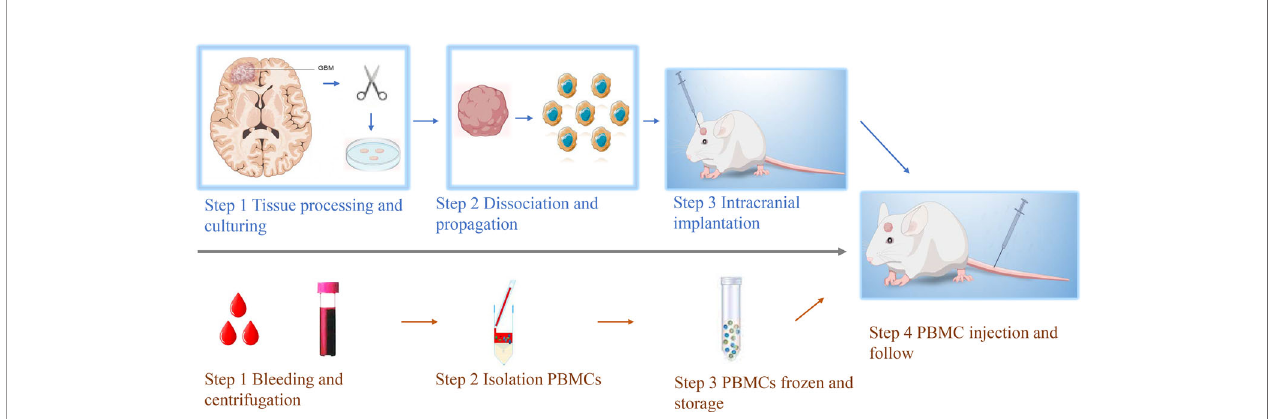
FIGURE 1 | Work fl ow of establishing GBM HPDOX mice models. Top, the work fl ow of establishing the GBM PDOX model. Tumor specimens obtained from surgery were dissociated to be single tumor cells. Then tumor cells were cultured with proper conditions to enhance the formation of GBM neurospheres (Top step 1). After the obtainment of neurospheres could be tested (Top, steps 1 & 2). GBM neurospheres could be used to establish the PDOX model to study tumor biology or test novel medicine and instruments (Top, step 3). Bottom, the work fl ow of establishing patients ’ PBMCs-derived humanized mouse models. The peripheral blood of GBM patients was collected and centrifugated (Bottom, step 1). The PBMCs were isolated and stored (Bottom, steps 2 & 3). After the establishment of the PDOX mice model for two weeks, the same patient ’ s PBMCs were injected into NSG mice for further study (step